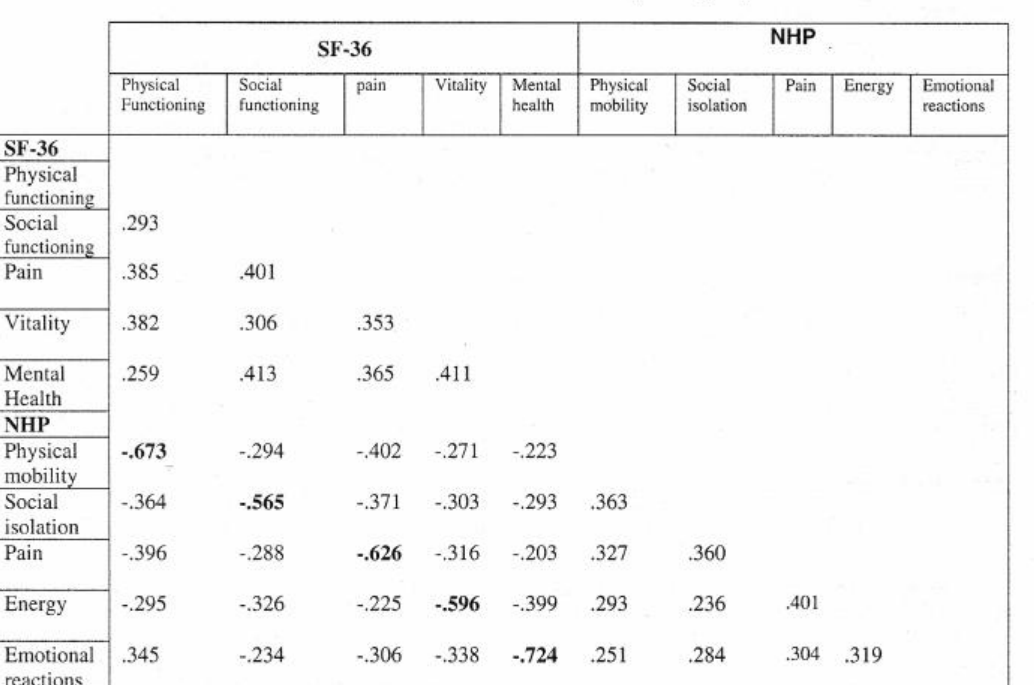
Table 3: MTMMofcorrelationcoefficients for SF-36 and NHP for comparison group